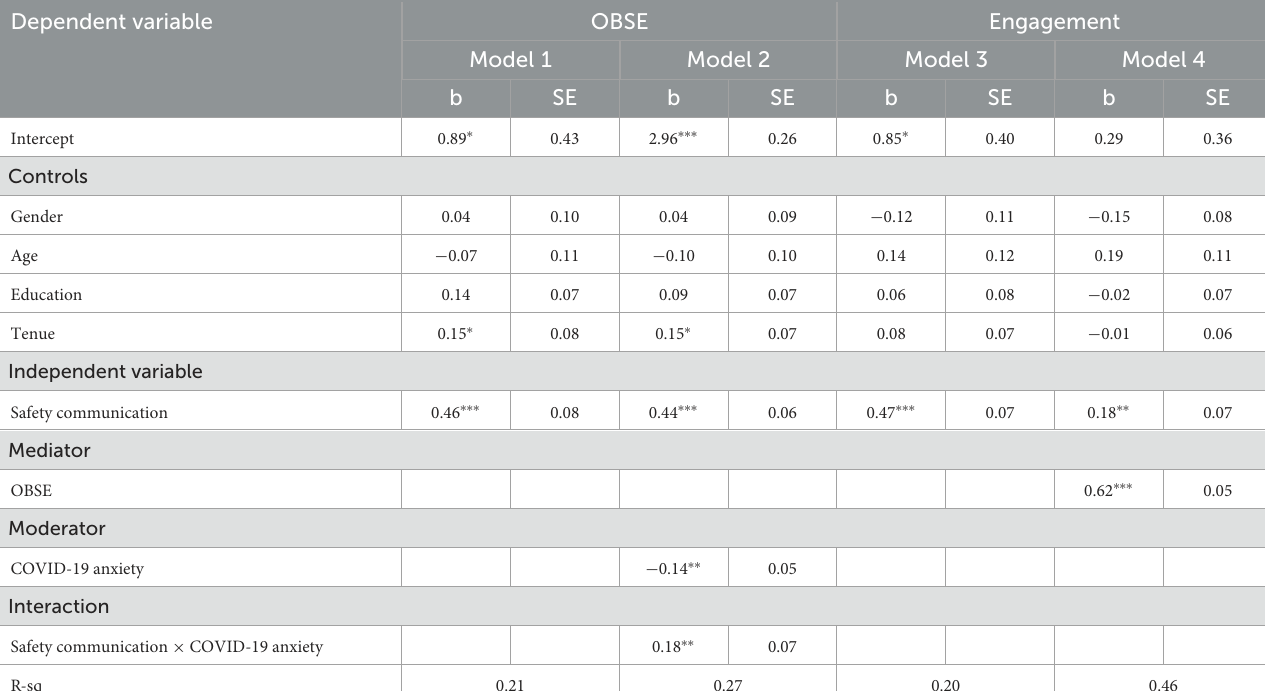
TABLE 3 Hierarchical regression analyses.